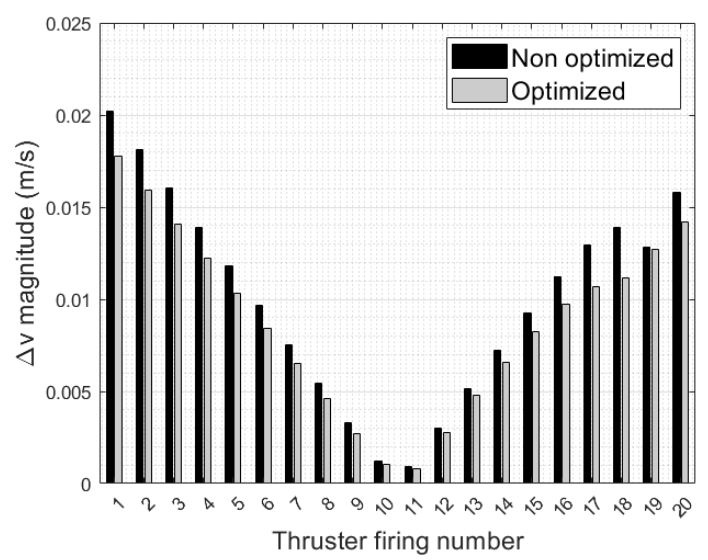
Figure 12. Fuel usage